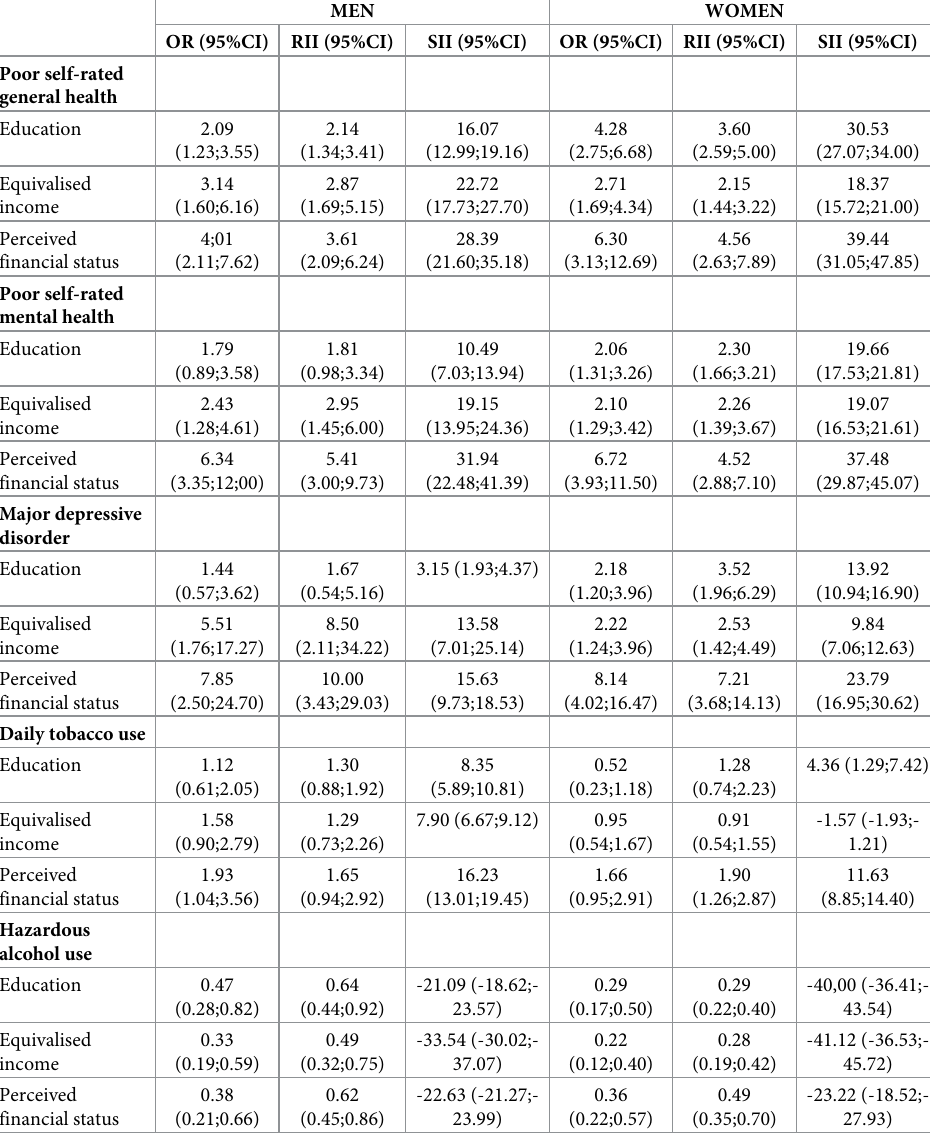
Table 3. Socioeconomic inequalities in health and substance use disorders according to socioeconomic position indicators: Odds ratio, relative index of inequality and slope index of inequality controlled for age, household type and migration characteristics (95% confidence